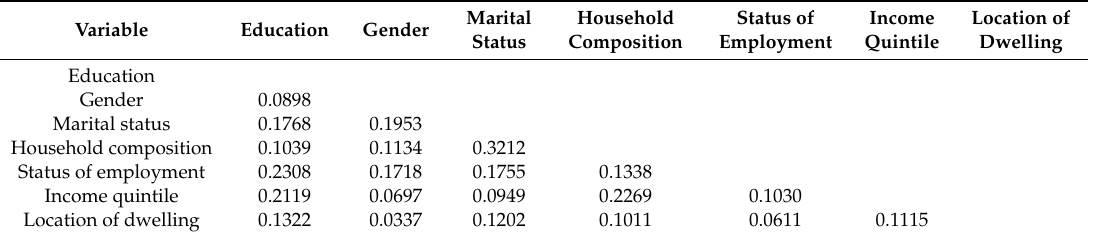
Table A1. Values of the Cramer’s V measure for 2014–2015 data.